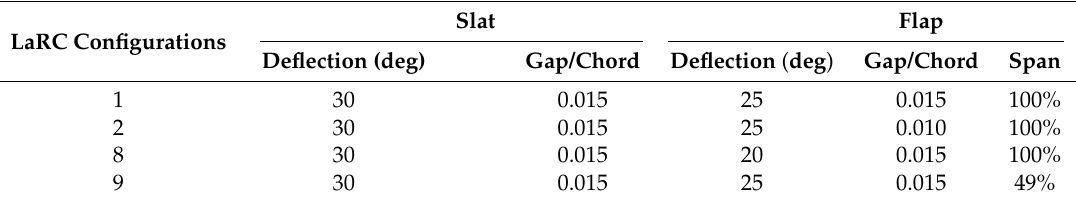
Table 2. Analysed NASA Trap Wing configurations from the LaRC 14 × 22 ft entry [19].